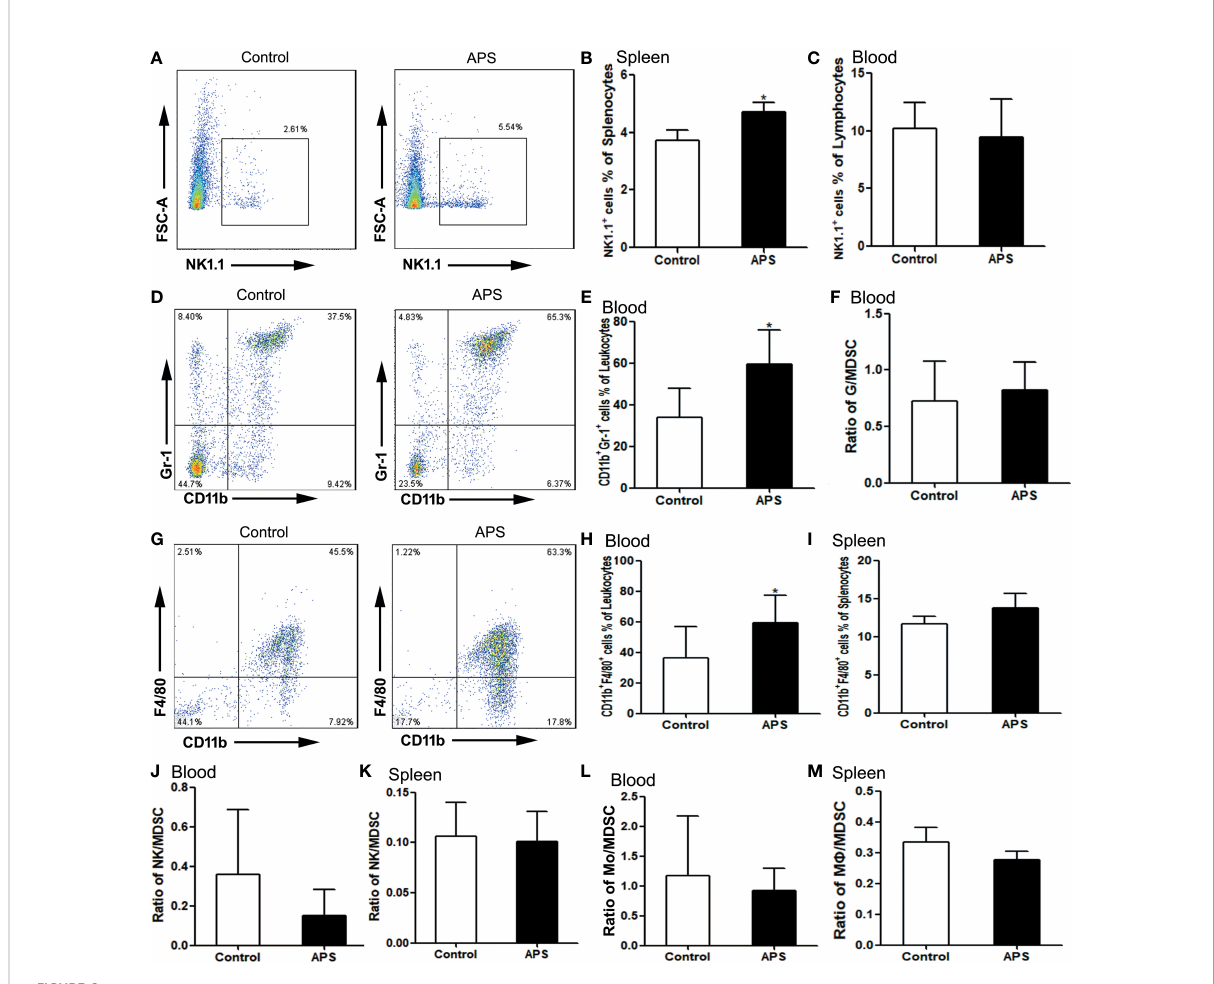
FIGURE 6 The percentages of NK cells, granulocytes and monocytes/macrophages in the spleen and peripheral blood. The spleen and peripheral blood were collected from the Control/APS-treated mice. Single-cell suspensions were generated, and the cells were immune-stained for CD19 and NK1.1. (A, D, G) One representative result from each experiment is shown. The percentages of NK1.1 + cells among the lymphocytes from splenocytes (B) and blood (C) (*p<0.05). (E) The percentages of CD11b + Gr1 + cells among the leukocytes in blood (*p<0.05). (F) The ratio of G/ MDSC in blood. The percentages of CD11b + F4/80 + cells among the leukocytes in blood (H) and splenocytes (I) (*p<0.05). (J) The ratio of NK/ MDSC in blood. (K) The ratio of NK/MDSC in spleen. (L) The ratio of Mo/MDSC in blood. (M) The ratio of M ɸ /MDSC in spleen. n=6, Data are expressed by mean ±